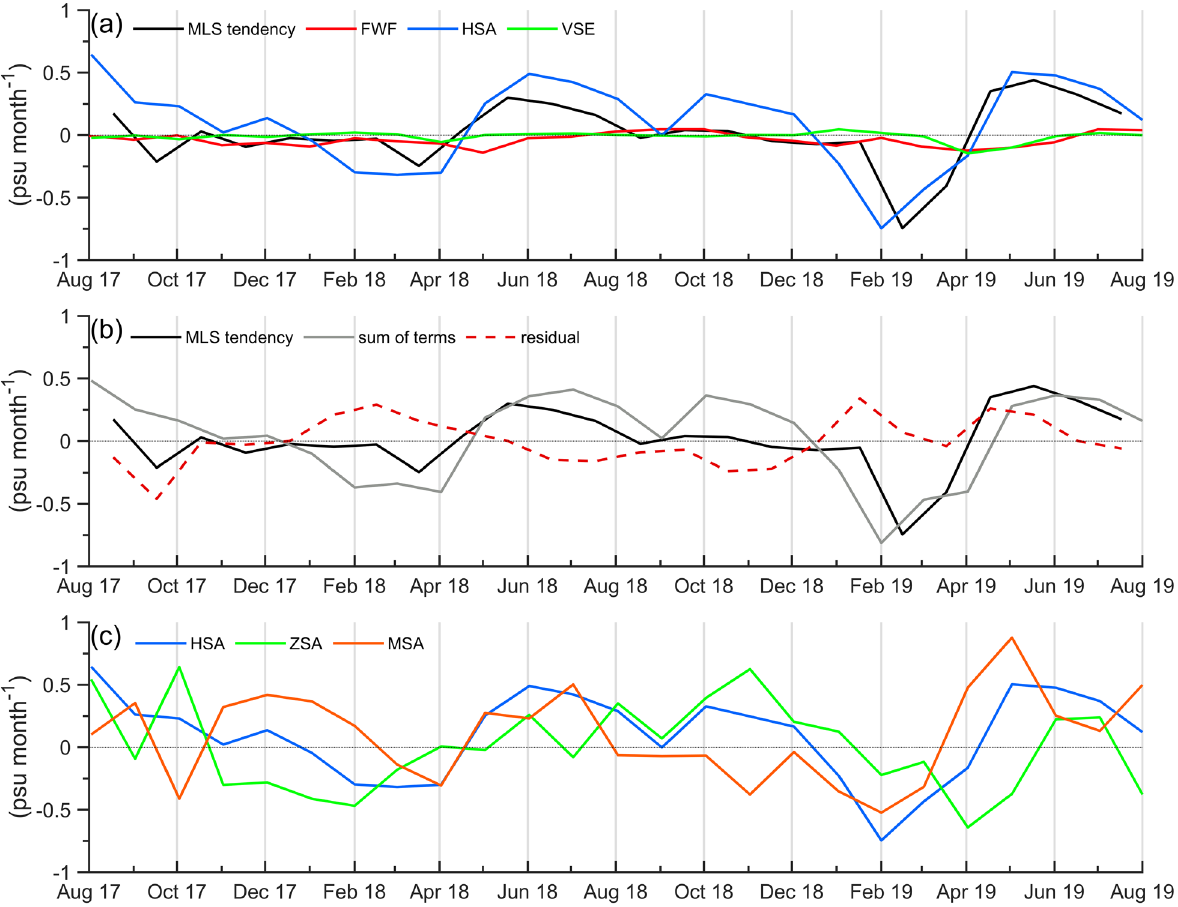
Fig. 3 Same as Fig. 2, but for the MLS balance (psu month − 1